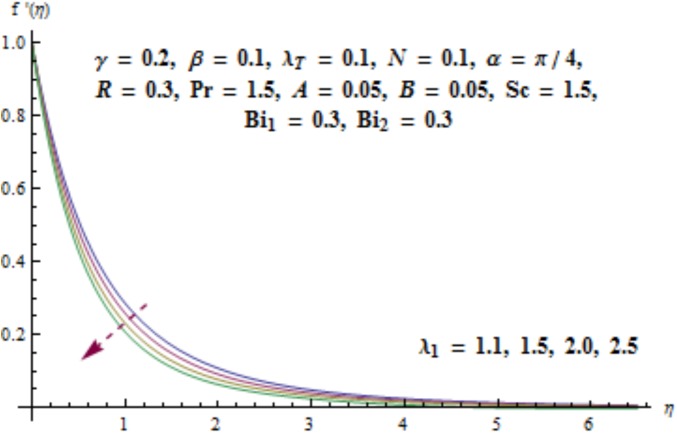
Behavior of λ1 on f'(η).